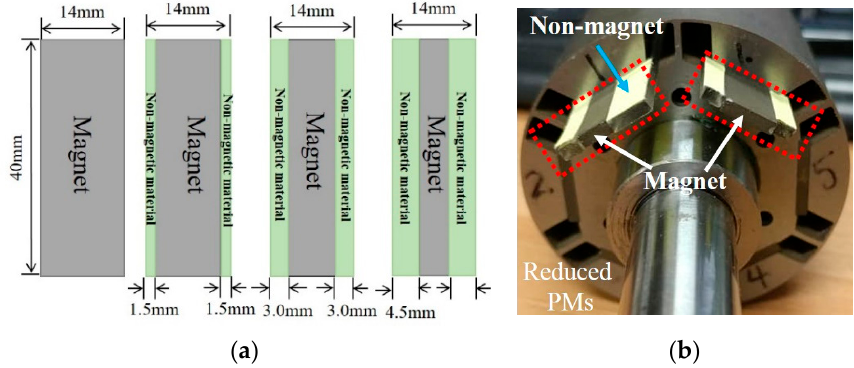
Figure 2. Demagnetization fault experimental setup: ( a ) schematic diagram of the reduced size permanent magnets (PMs); ( b ) rotor of permanent magnet synchronous motor (PMSM) with reduced size PMs and nonmagnetic material.